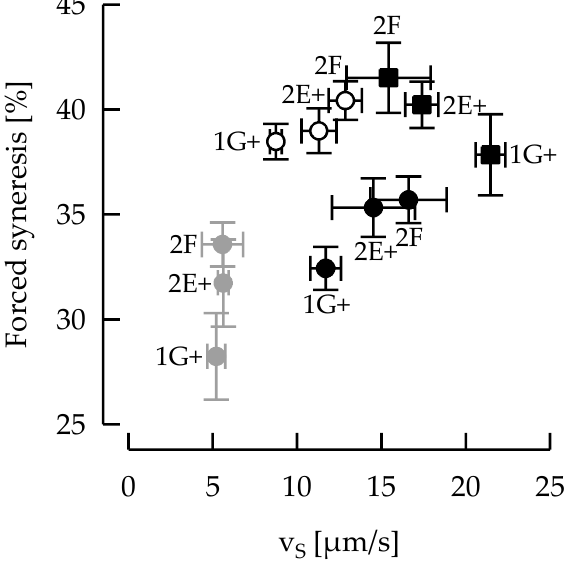
Figure 3. Forced syneresis after 3 d ( n = 12) versus sedimentation velocity (v S ) after 5 d ( n = 4) of cold storage of stirred gels from milk with a C/WP ratio of 4.0:1 after fermentation with low activity starters at 37 °C (white circles). Black circles, similar conditions but fermentation with high-activity starters. Black squares, fermentation with high-activity starters at 42 °C. Grey circles, fermentation of milk with a C/WP ratio of 1.5:1 with high-activity starters at 37 °C.